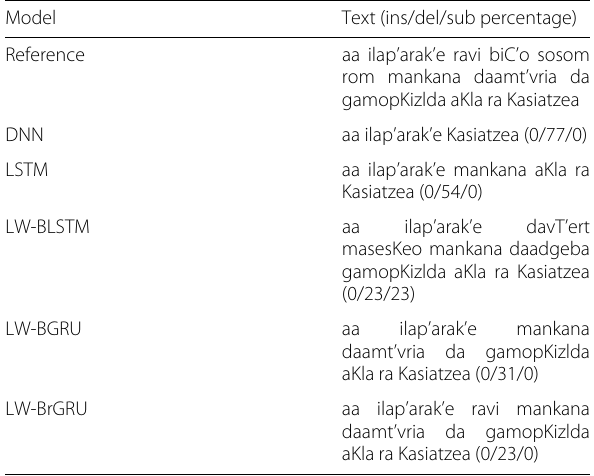
Table 15 The decoding results and word error rates of different models